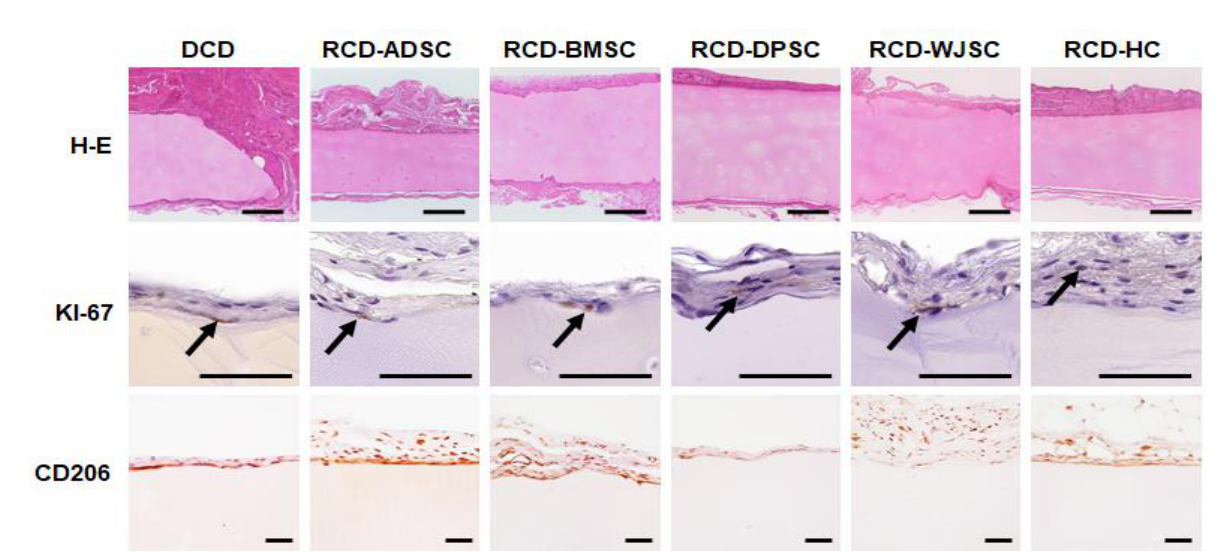
Figure 7. Histological analysis of samples grafted in vivo in laboratory animals, with H-E and immunohistochemistry for KI-67 and CD206. Arrows indicate representative cells with positive KI-67 staining. Scale bars: 200 µm.